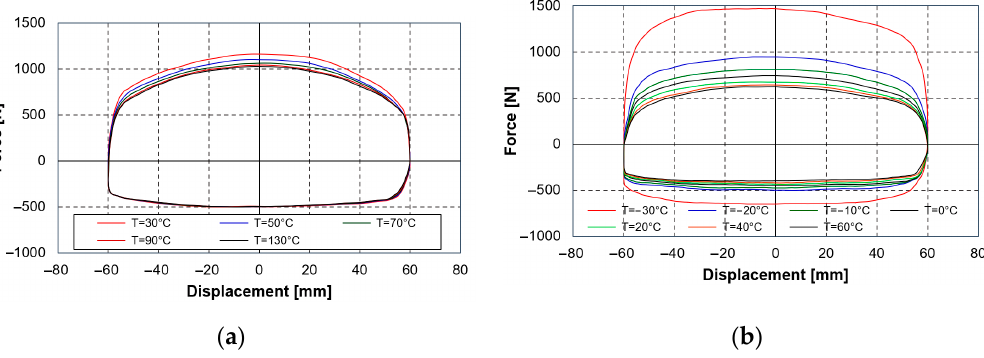
Figure 8. The influence of temperature on shock absorber force–displacement characteristics: ( a ) A = 60 mm, f = 1 Hz; ( b ) A = 60 mm, f = 0.5 Hz.